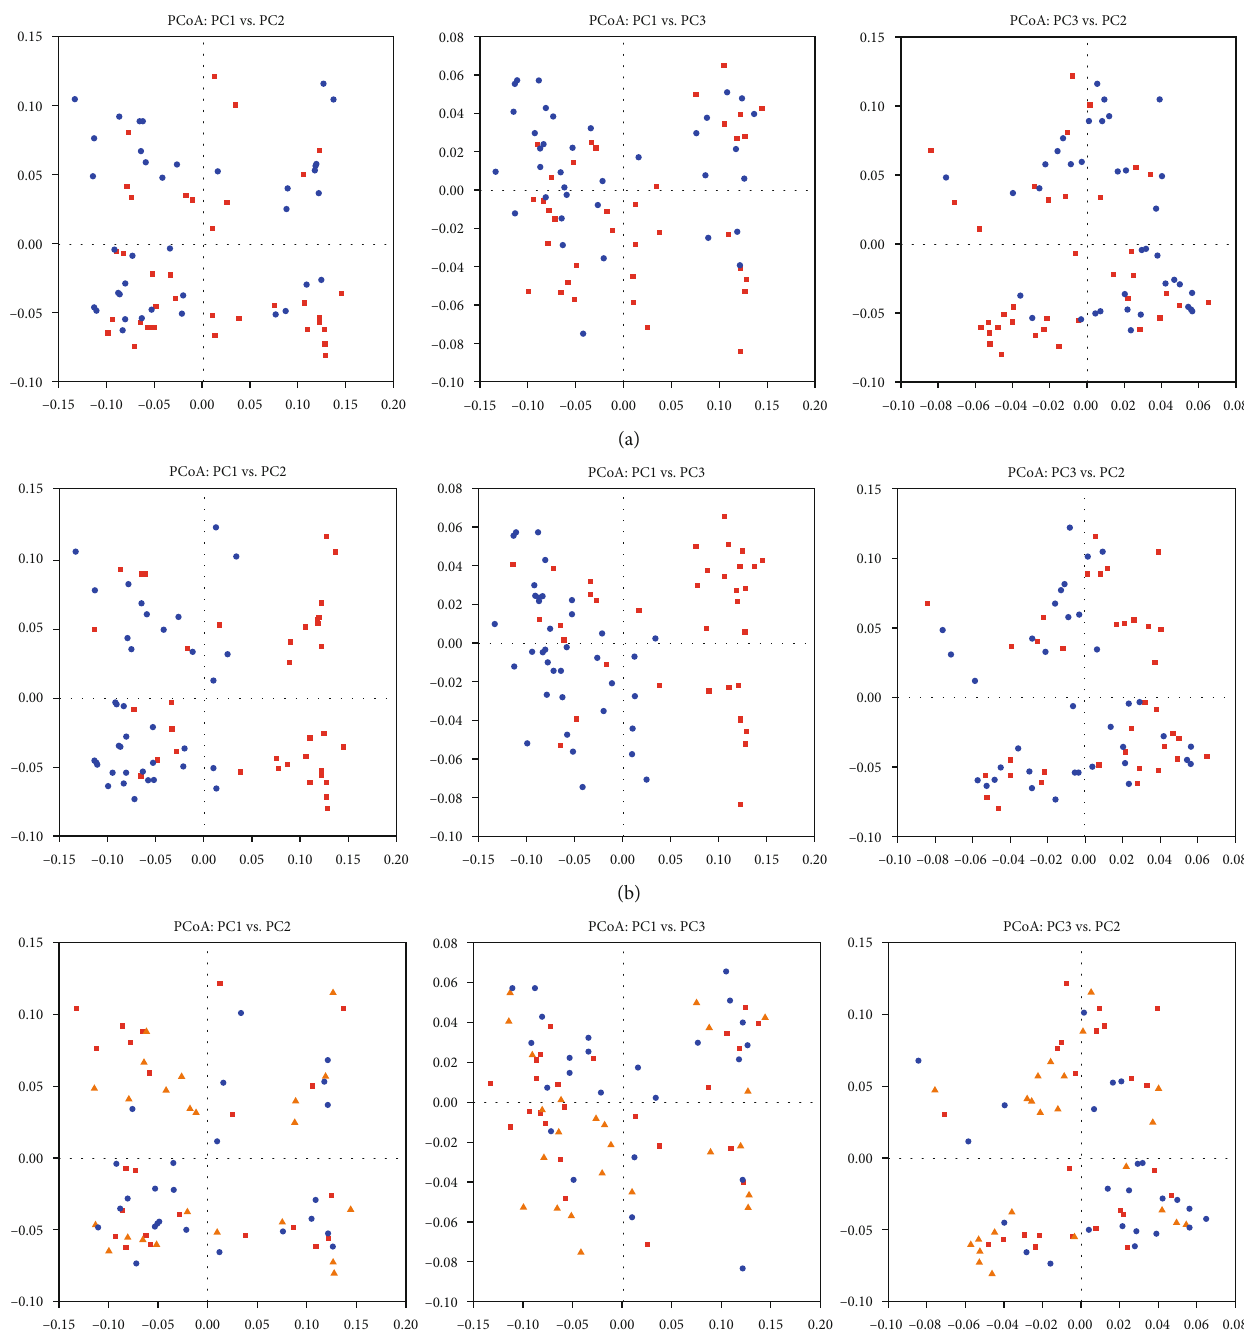
Figure 3: Principle coordinate analysis (PCoA) for beta-diversity of ruminal archaea in the solid phase of the incubation content of fermenters, under the e ff ects of (a) temperature (red squares: 39.5 ° C; blue circles: 42 ° C), (b) osmolality 1 (blue circles: normal; red squares: osmotic stress), and (c) betaine supplementation 2 (red squares: control; orange triangles: low; blue circles: high). The fi rst 3 components were plotted and in total principle component explained 77.61% of the total variation (PC1=47.78, PC2=21.46, and PC3 =8.37%, respectively). 1 Normal osmolality ~ 295 mOsmolkg − 1 ; hyperosmolality ~ 420 mOsmolkg − 1 . 2 Betaine levels: control (0), low (51), and high (286)